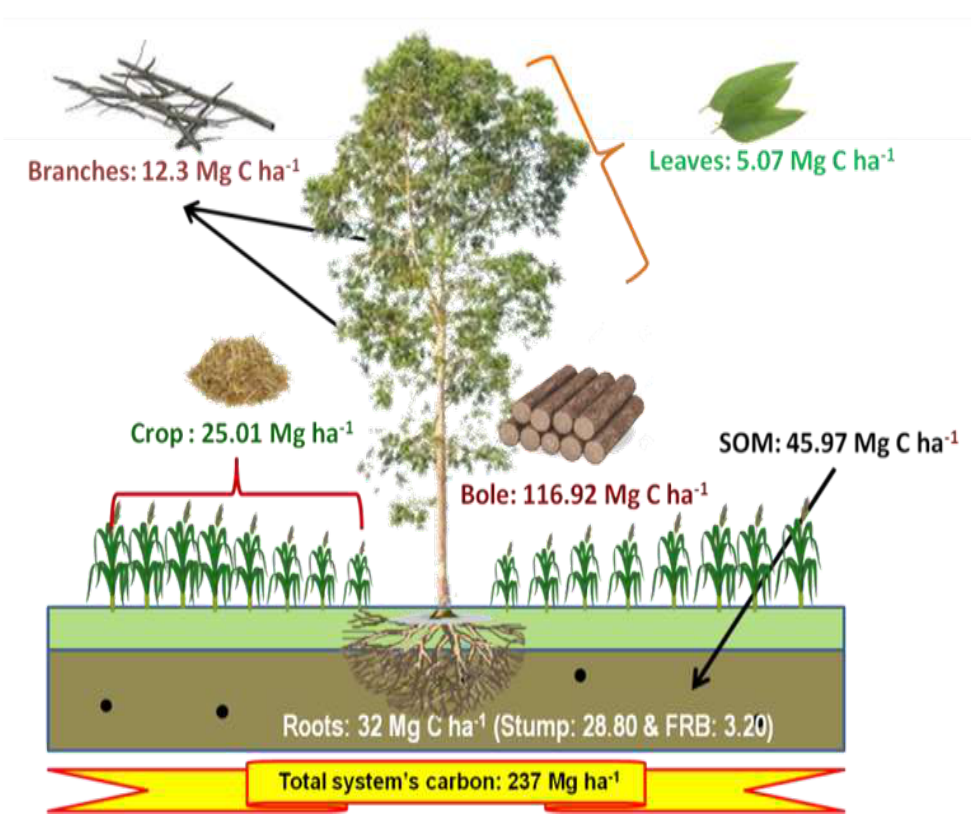
Figure 5. Total carbon stock (Mg ha − 1 ) of Dhaincha–barley crop rotation in eucalyptus-based agroforestry system (3 m × 3 m) over a rotation of 8